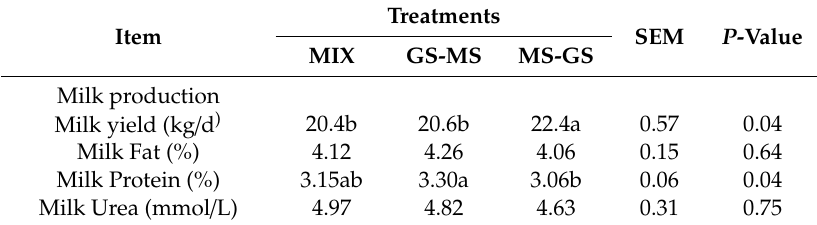
Table 3. Milk production and milk composition of grazing dairy cows supplemented with 50:50 grass and maize silage in the morning and afternoon (MIX), grass silage in the morning and maize silage in the afternoon (GS-MS) or maize silage in the morning and grass silage in the afternoon (MS-GS). Item